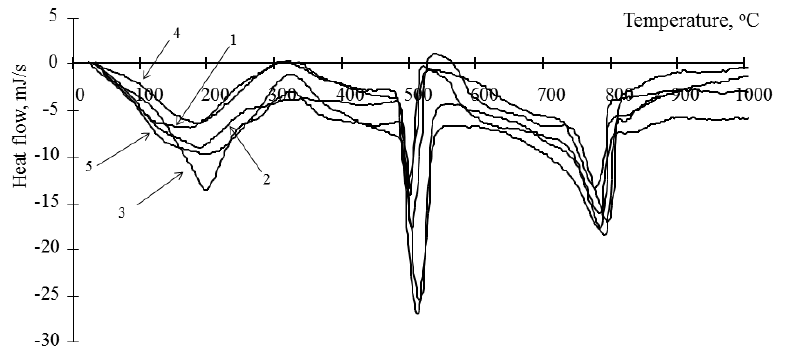
Figure 1. Thermogram of a cement stone modified with barium hydrosilicates and zinc hydrosilicates (0.5%): 1—at the age of 1 day; 2—at the age of 3 days; 3—at the age of 7 days; 4—at the age of 14 days; 5—at the age of 28 days.